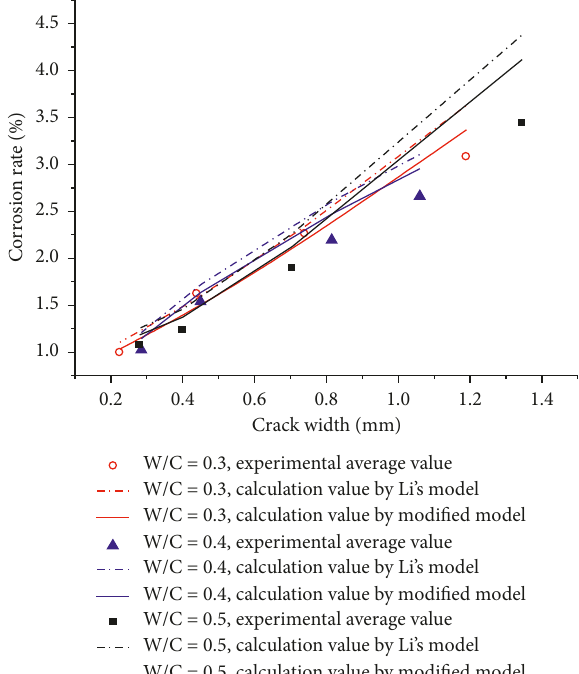
Figure 15: Comparison between Li’s model and the engineering formula with the test results (water-cement ratio is 0.3, 0.4, and 0.5; diameter of steel bar is